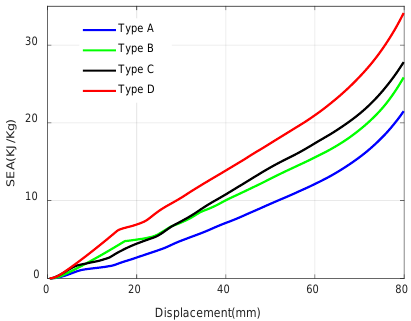
Figure 23. Comparison of four lattices in terms of quasi-static compressive SEA and displacement.